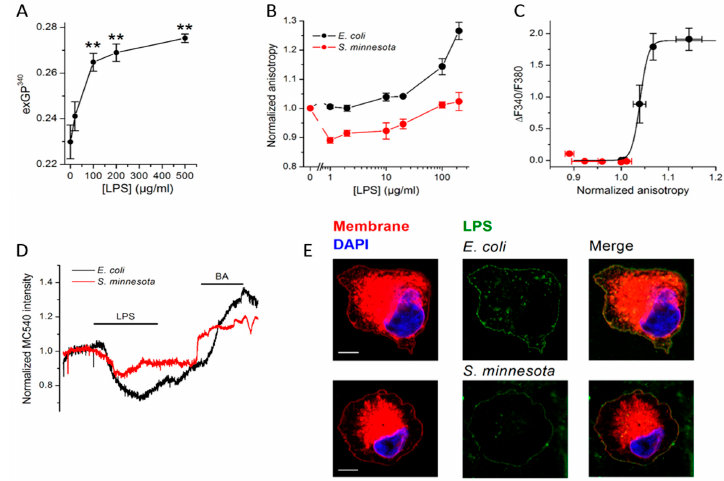
Figure 6. Effect of LPS insertion on membrane properties. ( A ) Determination of Laurdan excitation Generalized Polarization (exGP) is a useful tool in describing membrane fluidity as this probe displays a shift in the emission when in contact with ordered or disordered membranes [136,137]. The GP values recorded in one component lipid giant unilamellar vesicles (GUV) are between − 0.3 to 0.3 corresponding to the fluid and between 0.5 and 0.6 in gel phase [138]. The exGP values determined in DPPC GUVs indicate membrane rigidification induced by E. coli LPS. ( B ) Fluorescence anisotropy of membrane sensitive dye diphenylhexatriene (DPH) changes upon alterations of the membrane fluidity. Intercalation of E. coli LPS into CHO-mTRPA1 membranes caused anisotropy increase demonstrating reduction in its fluidity. Contrary, S. minnesota LPS that did not prompt significant changes. ( C )